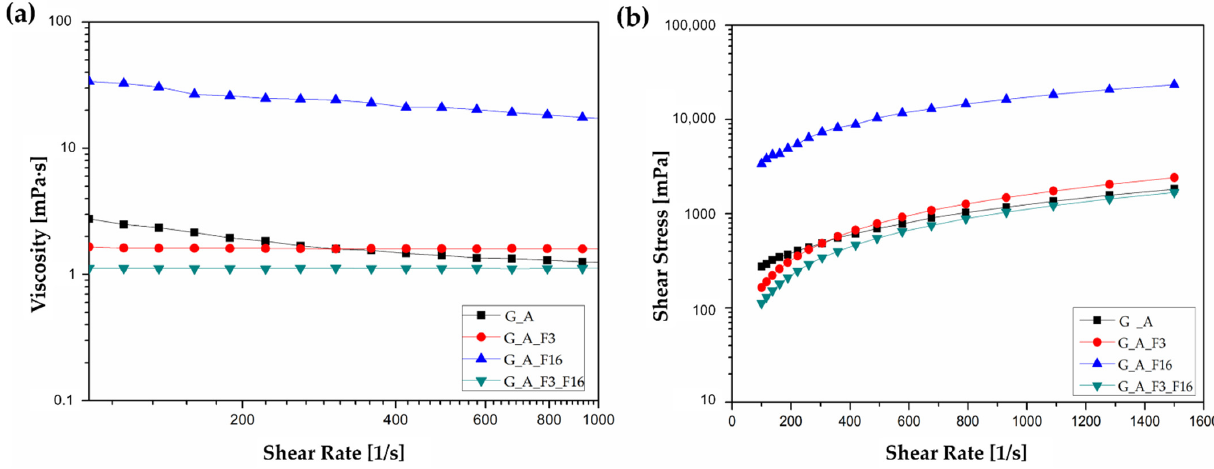
Figure 10. ( a ) Viscosity vs shear rate and ( b ) flow curves of the coatings at room temperature. Viscosity generally represents the flow resistance of materials based on the interac- tion between the components. The results revealed that the viscosity was almost depend- ent on the shear rate, behaving like a Newtonian fluid, and it gradually decreased with increasing shear rate, indicating shear thinning properties. [71]. Across the entire measur- ing range, the coating G_A_F16 exhibited a higher viscosity of η = 22.94 mPa·s within the shear rate range shown (100 s − 1 to 1000 s − 1 ), while the coatings G_A, G_A_F3 and G_A_F3_F16 remains constant, thus showing ideally viscous flow behavior with η = 1.68 mPa·s, η = 1.60 mPa·s and η = 1.12 mPa·s, respectively. The measuring results of viscosity curves are presented as a diagram with shear rate plotted on the x-axis and viscosity plot- ted on the y-axis; both axes are presented on a logarithmic scale. The relationship between the shear stress and shear rate of the coatings is shown in Figure 10b. 2.3. Evaluation of Antifouling Properties and Characterization The microscopic analysis carried out on untreated (control) and treated glasses showed significant differences in adhered cells between untreated and treated glasses. 2.3.1. LM and EM Figure 11 summarizes all the results of the percentage of adhesion of the three micro- organisms tested as compared to the untreated control (=100%). Each set of experiments carried out with the three microorganisms is shown in the following figures. Figure 12 shows the results obtained with the Gram-negative strain S. maltophilia (BC 658). All glass slides treated with the four sols determined a significant decrease in adher- ing cells with respect to the control. G_A covered glass slide reduced the adhered cells number to 76.5% with respect to the control. G_A_F3 and G_A_F16 reduced significantly the adhering cells number, respectively, to 29.5% and 53%. G_A_F3_F16 showed also an FR activity decreasing the adhering cells number to 71% with respect to the control. G_A_F3 coated glass slide showed the best FR attitude against the Gram-negative strain.